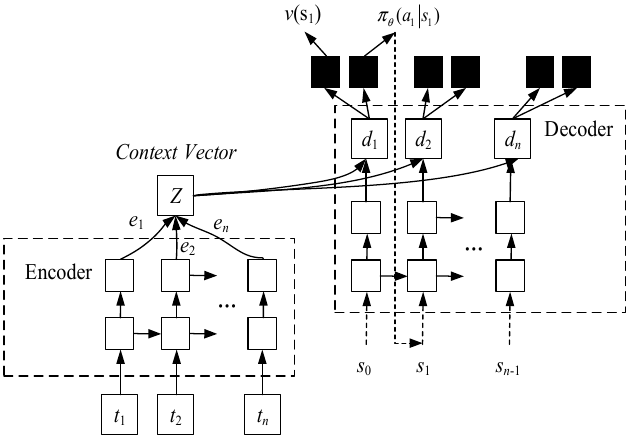
Figure 1. S2S Neural Network Framework.